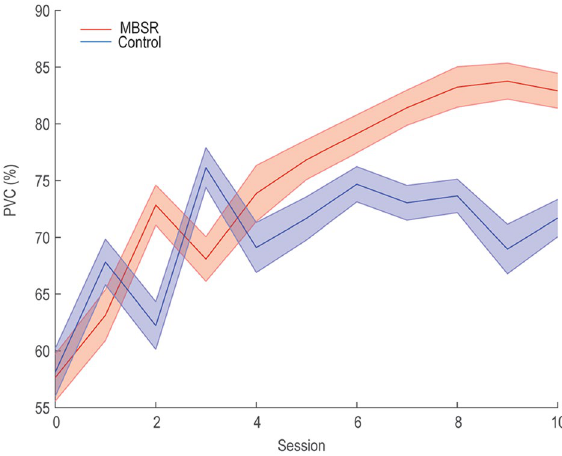
Figure 1. BCI performance changes over training sessions. The performance was assessed by percent valid correct (PVC).